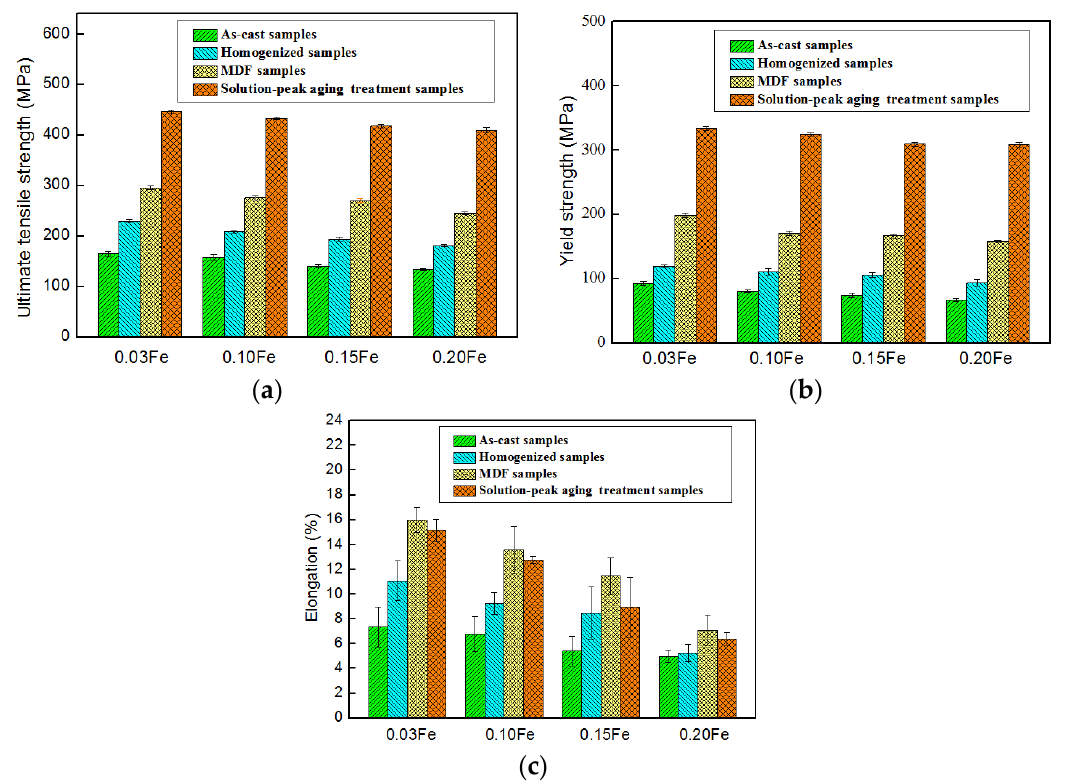
Figure 8. Mechanical properties of 2219 Al–Cu alloys with different processes: ( a ) The ultimate tensile strength; ( b ) the yield strength; ( c ) elongation.